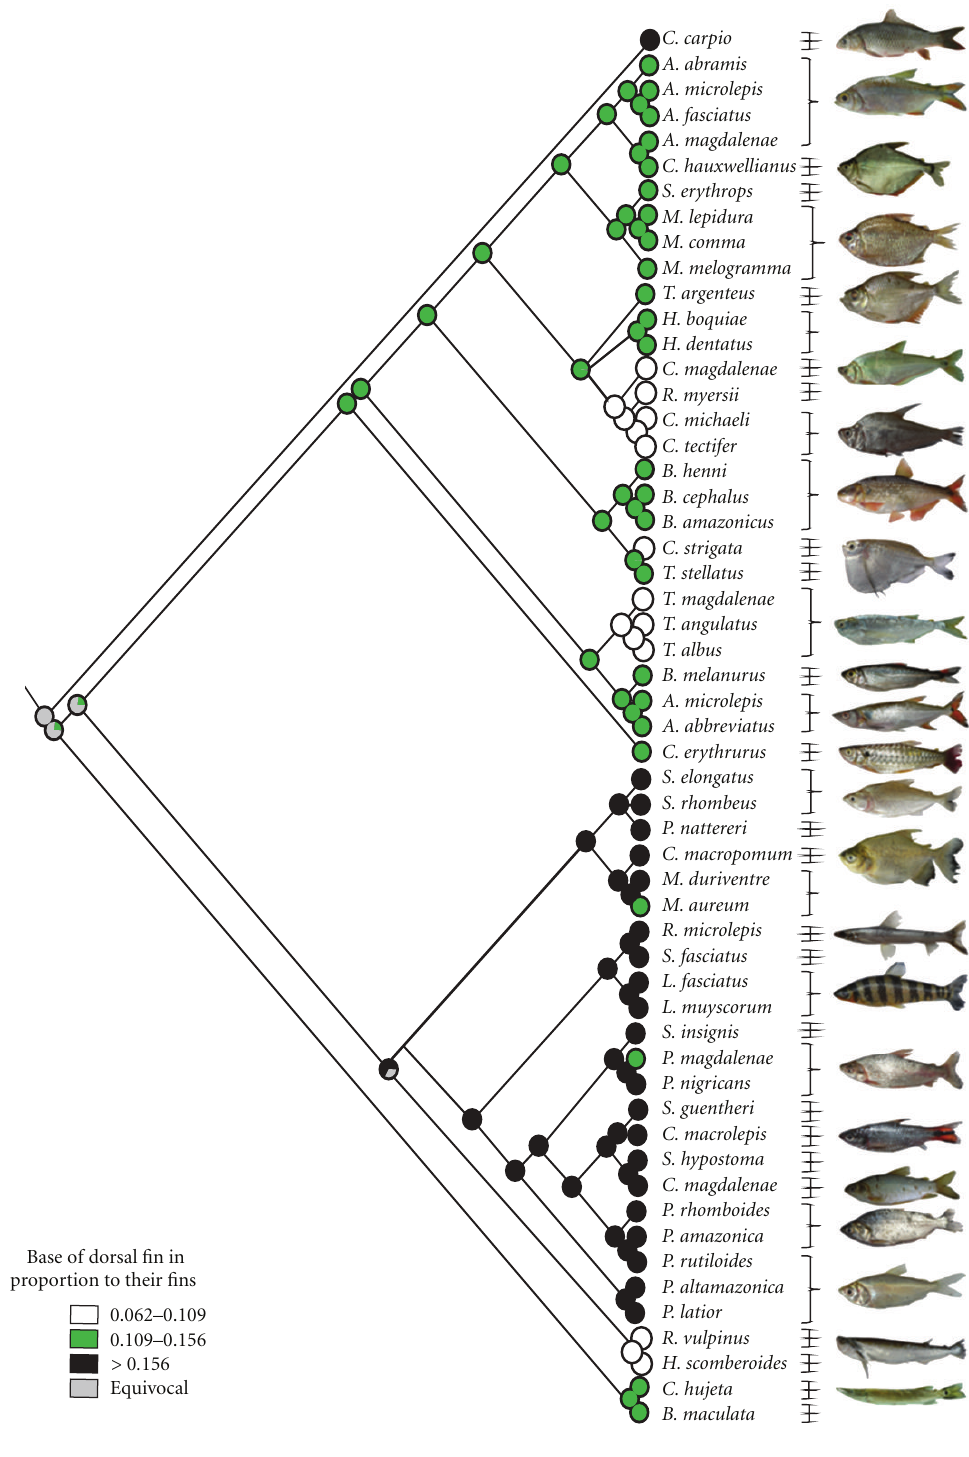
Figure 7: Reconstruction of size of dorsal fin in proportion to other fins shown on consensus tree in 800 trees with Bayesian inference. Pie charts at major nodes show posterior probabilities from stochastic analysis of ancestral state reconstructions assuming that character-state evolution is